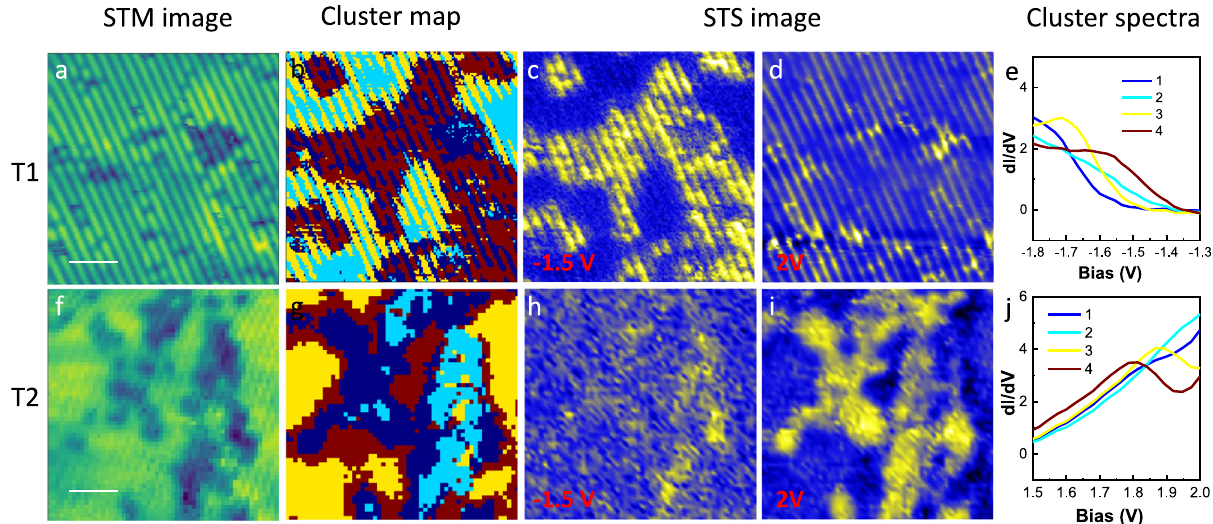
Fig. 5 Local electronic behavior of T1 (a-e) and T2 (f- j). STM images ( a , f ), cluster maps ( b , g ), − 1.5 V STS maps ( c , h ), 2 V STS maps ( d , i ) and cluster spectra ( e , j ) for T1 and T2, respectively. Image size 20 nm × 20 nm, the scale bars represent 4 nm. See text for the meaning of colors in cluster maps and